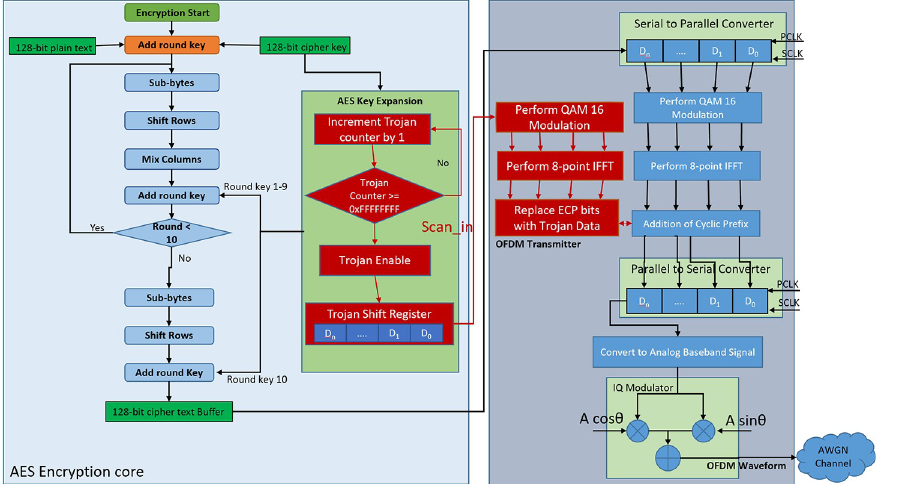
Fig 9. Flowchart of HT infested wireless transmitter